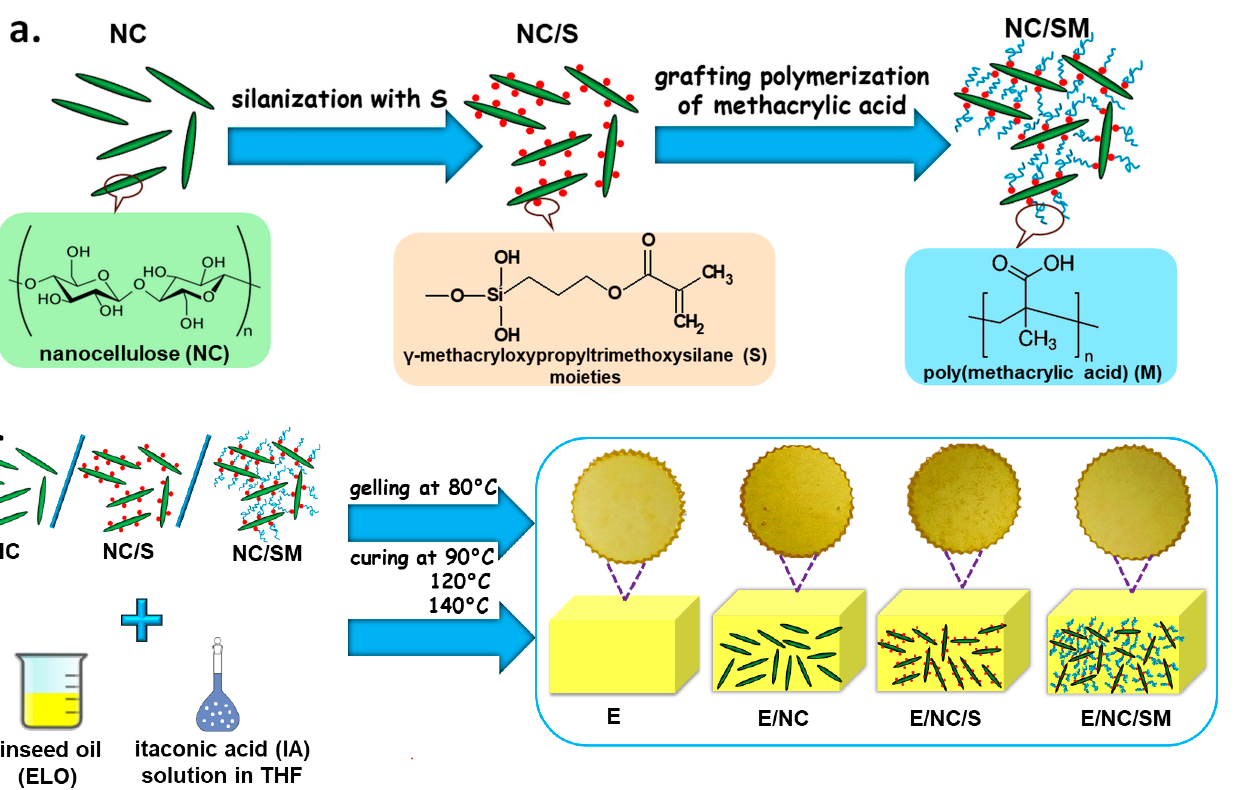
Figure 1. Graphical representation of NC grafting ( a ) and of the obtaining procedure for the ELO/NC nanocomposites ( b ).